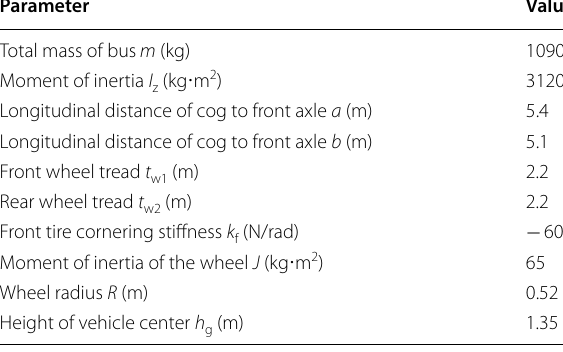
Table 1 Bus simulation parameters